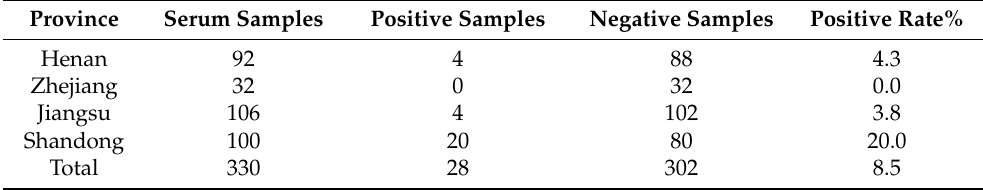
Table 4. Detection of anti-ASFV antibodies in pig serum samples from different